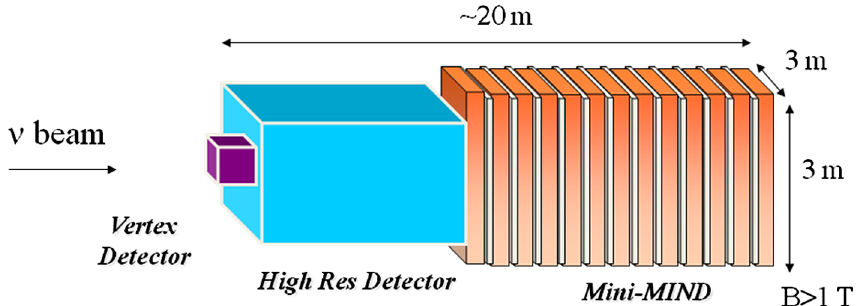
FIG. 24. The near detector for a Neutrino